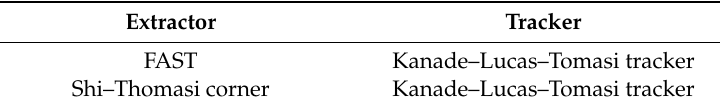
Table 2. The feature tracking method combinations.